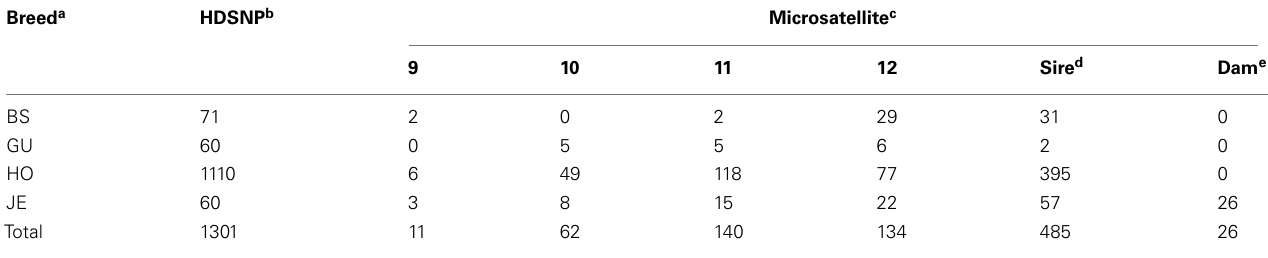
a Breed abbreviations: BS, Brown Swiss; GU, Guernsey; HO, Holstein; JE, Jersey. b Count of individuals with HDSNP genotypes. c Count of individuals with genotypes for 9, 10, 11, or 12 microsatellite loci. d Count of sires with marker genotypes from microsatellites. e Count of dams with marker genotypes from